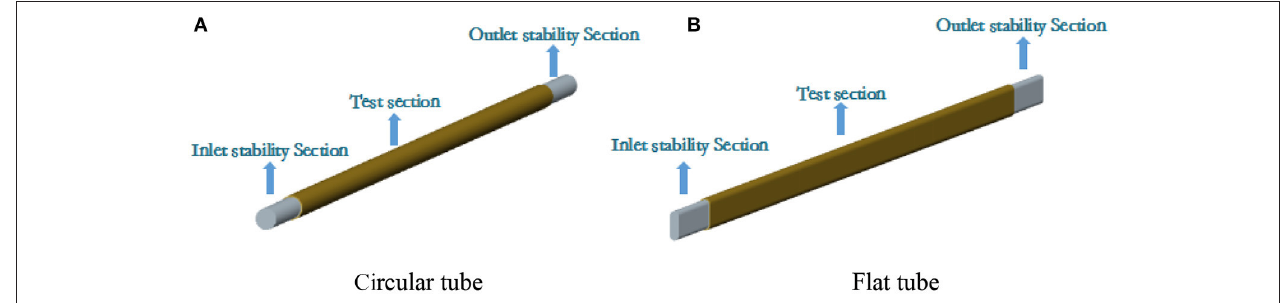
FIGURE 2 | Calculation model.